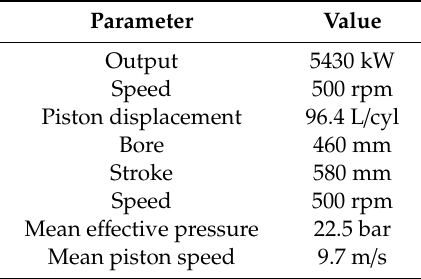
Table 1. Characteristics of the engine at 100%